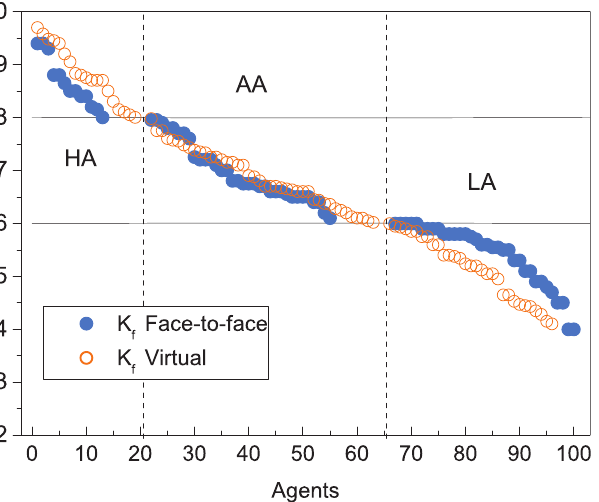
Fig 1. Group classification of students into three different sets according to their final grade as High-achieving (HA) students, Average-achieving (AA) students and Low-achieving (LA) students for N = 173.